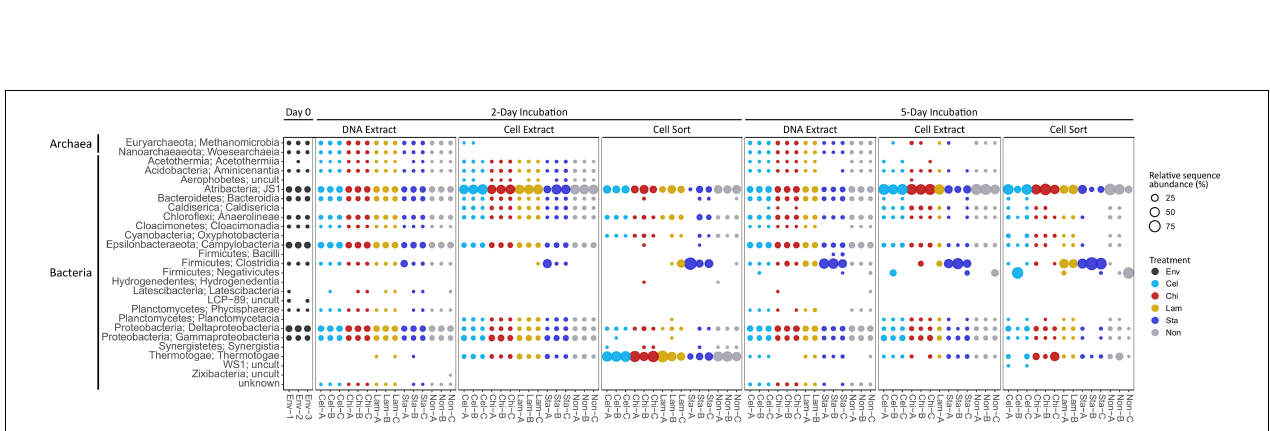
FIGURE 2 | Community composition on class level showing relative sequence abundance (%) for taxa occurring with > 1% in at least one sample. Env: environmental sample (inoculum), Cel: cellulose, Chi: chitin, Lam: laminarin, Sta: starch, Non: no amendment.